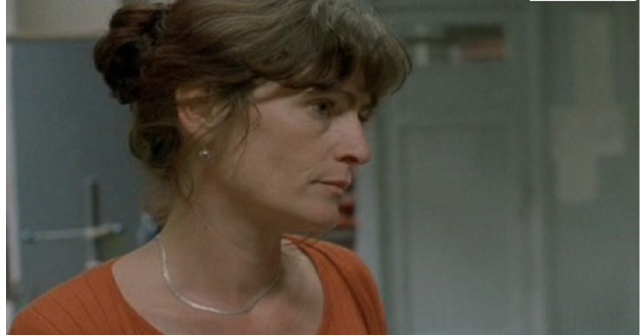
Figure 4. Apprehension.